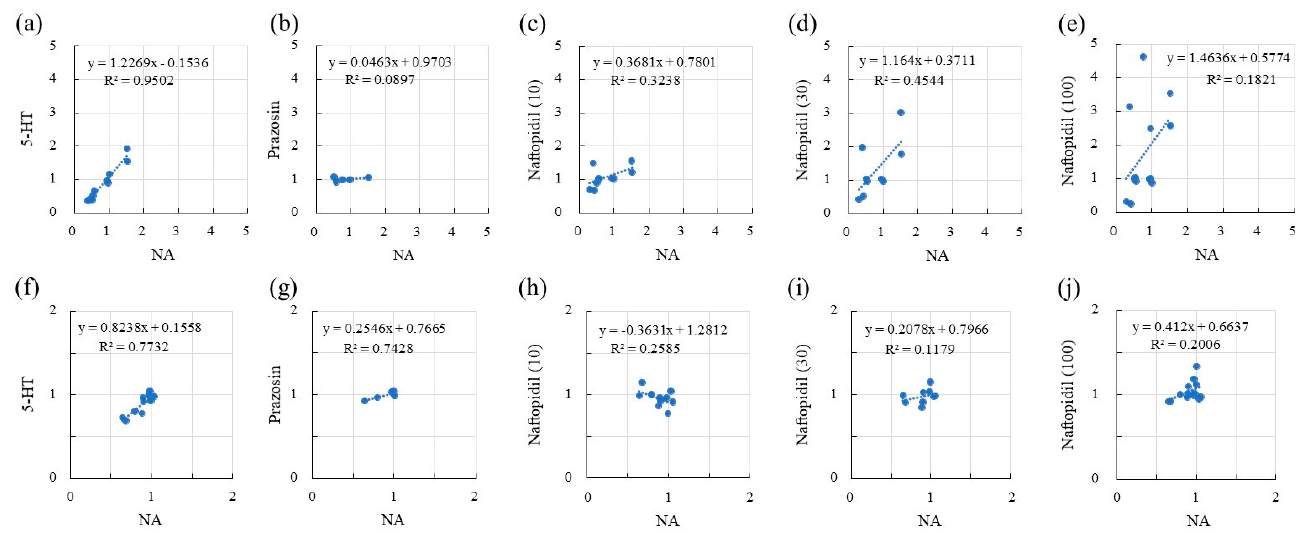
Figure 5. The association between NA (50 μ M) and each ligand for the response ratios of sEPSCs in the SG neurons of spinal cords isolated from rats. Scatter plots for frequency were created for the association with NA of 5-HT (50 μ M) ( a ), prazosin (10 μ M) ( b ), and naftopidil (10, 30, and 100 μ M) ( c – e , respectively). Similarly, for amplitude, the associations between NA and 5-HT (50 μ M) ( f ), prazosin (10 μ M) ( g ), and naftopidil (10, 30, and 100 μ M) ( h – j , respectively) are presented. The x and y axes reveal the ratio of frequency or amplitude of sEPSCs after adding the drugs (NA, 5-HT, prazosin, or naftopidil) to before the adding in the single SG neuron. Each dot in the figures is shown as a response of the individual SG neuron.